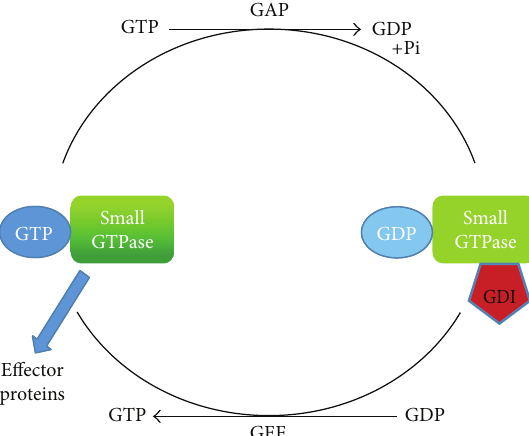
Figure 4: Small GTPases act like a molecular switch. Small GTPases are active when they are GTP bound and inactive when they are GDP bound. The switch between active and inactive state is mediated by modulators, mainly GAPs (GTPase activating proteins) and GEFs (guanosine exchange factors). GAP hydrolyzes the bound GTP to GDP and GEF exchanges the GDP with GTP. Besides GAPs and GEFs, there is another kind of modulators—GDI (GDP dissociation